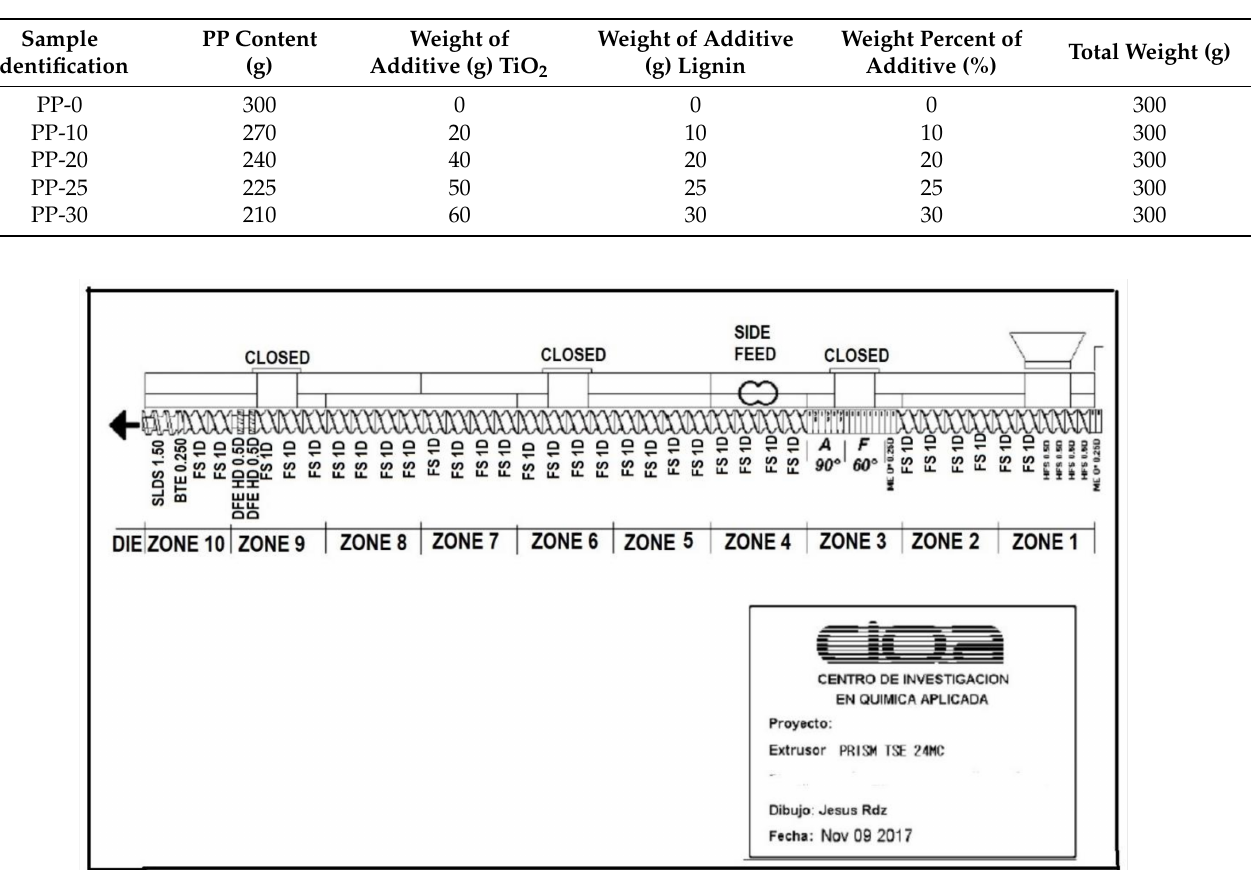
Table 1. Identification of the PP/TiO 2 /lignin composites with different percentages of additives (10, 20, 25, and 30 wt.%).